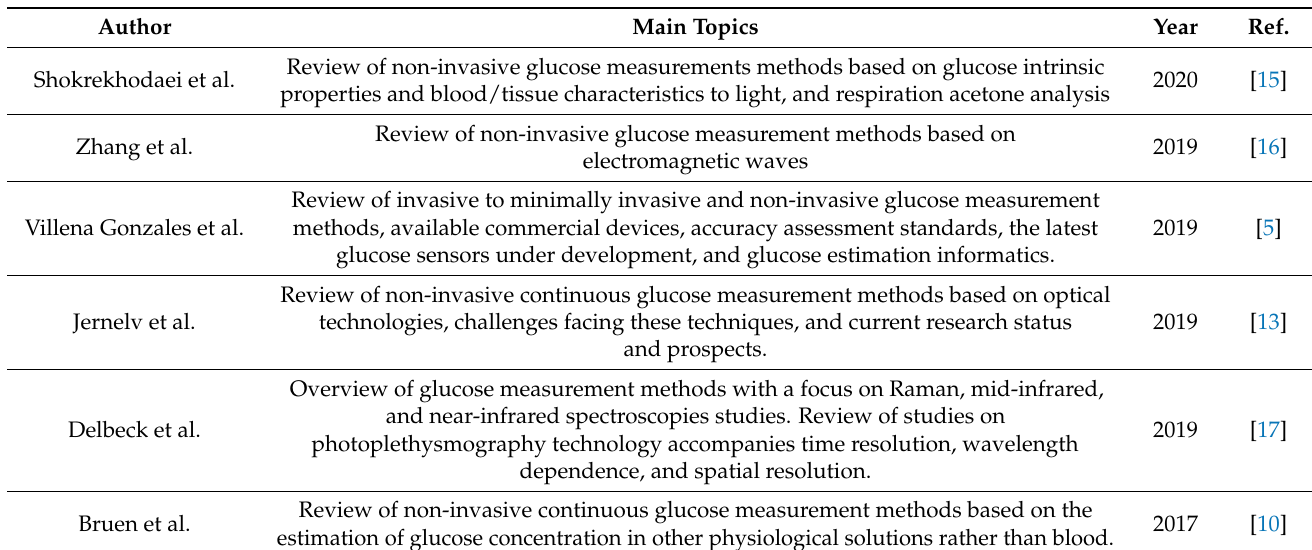
Table 1. Summary of some review papers most pertinent to non-invasive glucose sensing